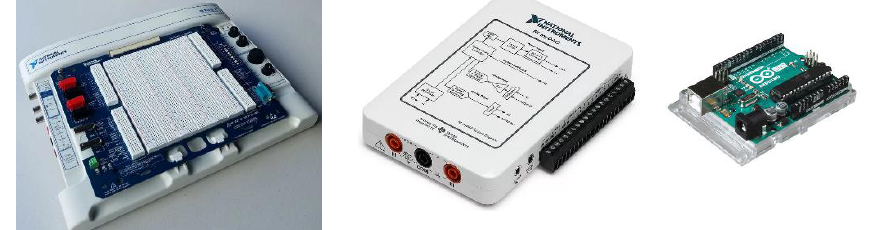
Fig. 2. Hardware systems ELVIS II, myDAQ and ARDUINO.